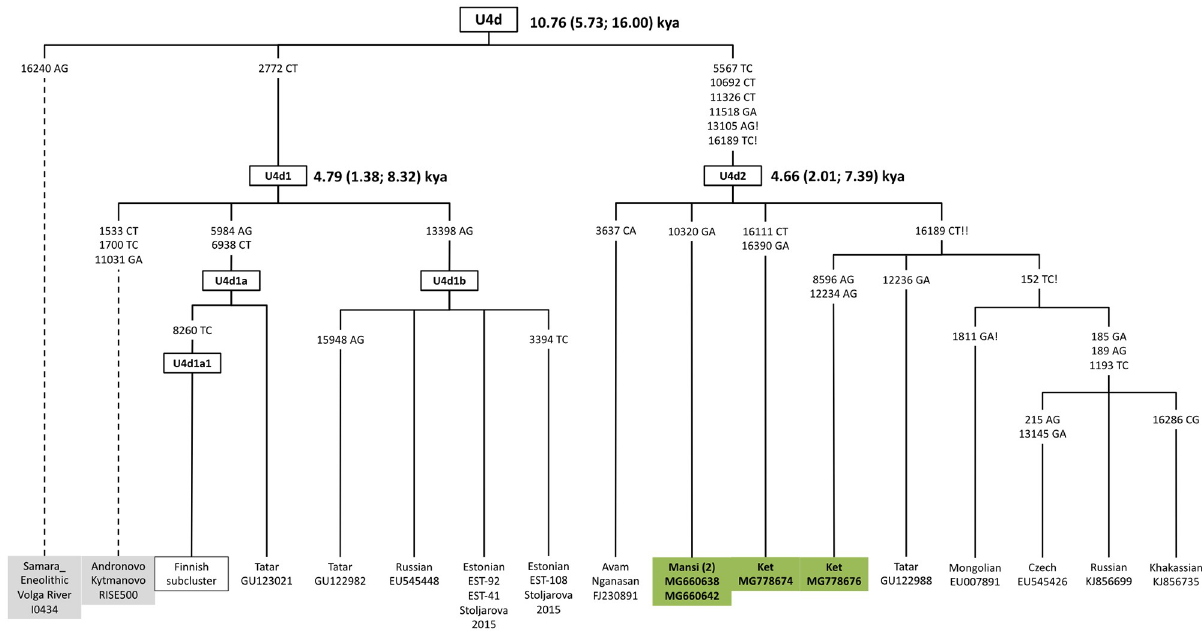
Fig 4. A phylogeny of complete U4d sequences compared with a couple of ancient (incomplete)